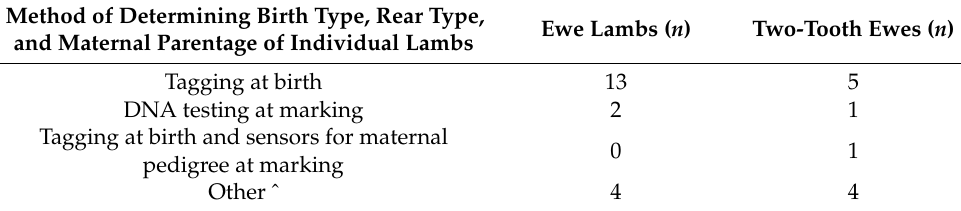
Table 2. The number of flocks which determined birth type and rear type of lambs born to ewe lambs and maiden two-tooth ewes by tagging at birth, DNA testing at marking, tagging at birth and using sensors for maternal pedigree at marking, and those using other methods to assess lamb birth type, lamb birth status and whether ewes were rearing a